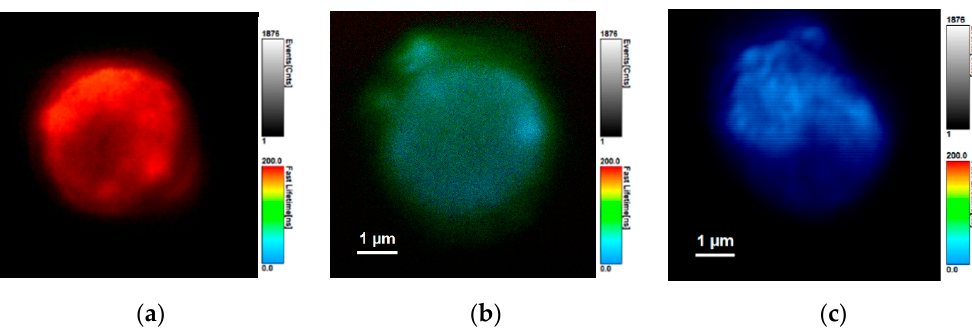
Figure 7. Fluorescence lifetime images of the microspheres doped by QDs and QDs with Cy3 or Cy5 dyes measured at maxima of QD PL and the FRET-induced dyes PL. ( a ) PMS-AIS ( λ PL = 665 nm, < τ > = 245 ns), ( b ) PMS-AIS-Cy5 L2 ( λ PL = 665 nm, < τ > = 160 ns) and ( c ) PMS-AIS-Cy3 L2 ( λ PL = 580 nm, < τ > = 80 ns). PL wavelengths ( λ PL ) and corresponding average PL decay times < τ > are shown. The color scales of PL lifetimes are